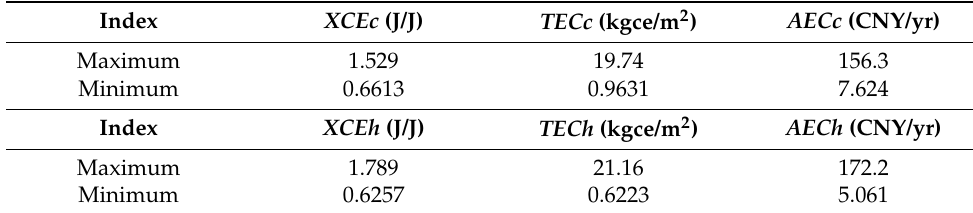
Table 2. Extreme values of